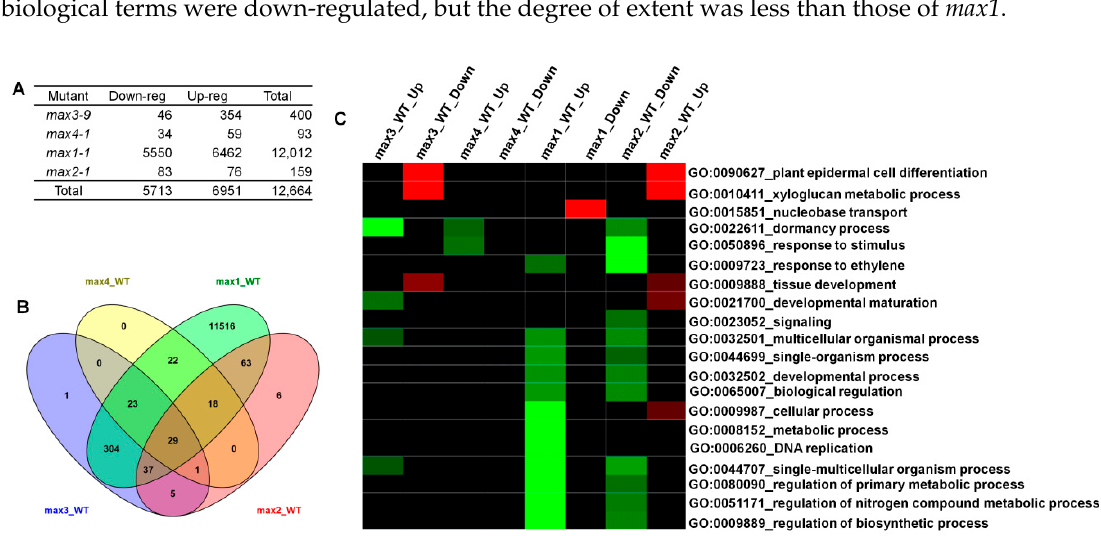
Figure 2. Microarray analysis of the gene expression profiles in max mutants compared with wild-type. ( A ) Significantly changed genes in max mutants compared with wild-type. ( B ) Venn diagram for several genes that changed expressed levels in mutants compared with those of wild-type control. ( C ) Heatmap of differentially expressed Gene Ontology (GO) in all four max mutants. Panel on the right side of the heat map shows the GO identity and its role in various biological processes. Red boxes in the heat map show up-regulated GO, green boxes show down-regulated GO, and black boxes show unchanged GO expression in four max mutants.